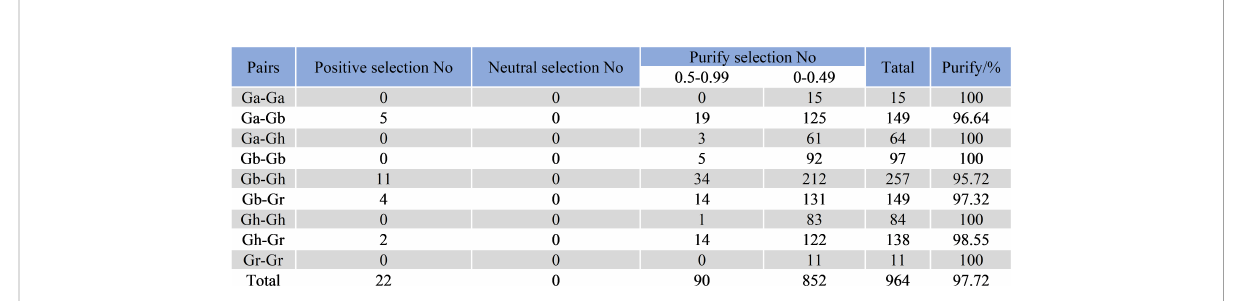
FIGURE 6 Prediction of no of duplicated gene pairs involved in different combinations from four Gossypium